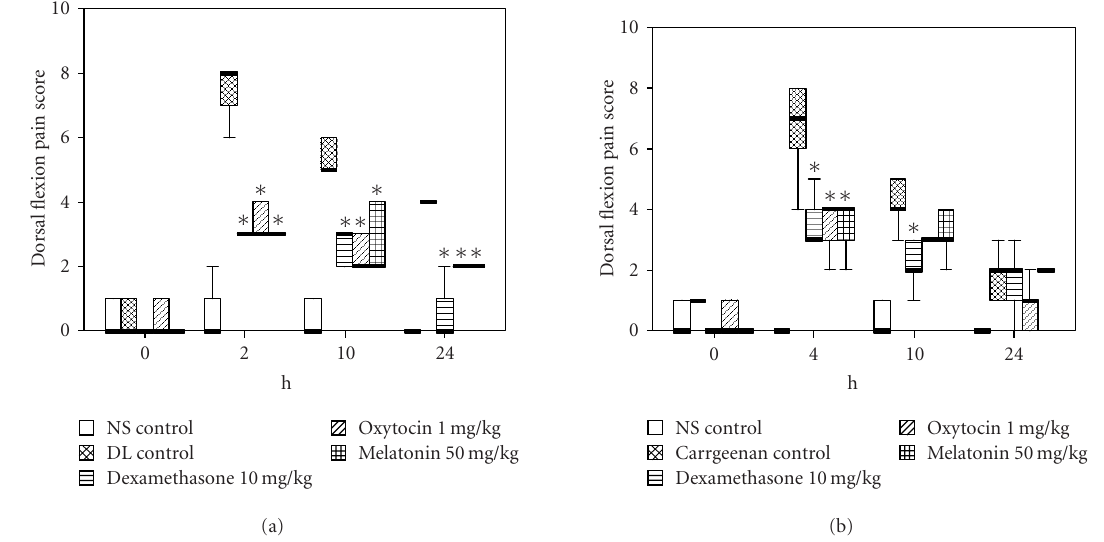
Figure 2. Antihyperalgesic e ff ect of various drugs on (a) DL- and (b) carrageenan-induced inflammatory hyperalgesia. Edema was induced by injecting 0.1 mL of 1% solution of DL or carrageenan into the subplantar surface of right-hind paw. The drugs were administered subcutaneously 30 minutes before injecting inflammagen. Dorsal flexion pain score was recorded at di ff erent time intervals ( n = 6). The data is illustrated as box plots where bold line represents median values, boxes represent interquartile ranges (25th and 75th percentiles), and whiskers represent extreme values. NS control. ∗ P < . 05 versus respective control.